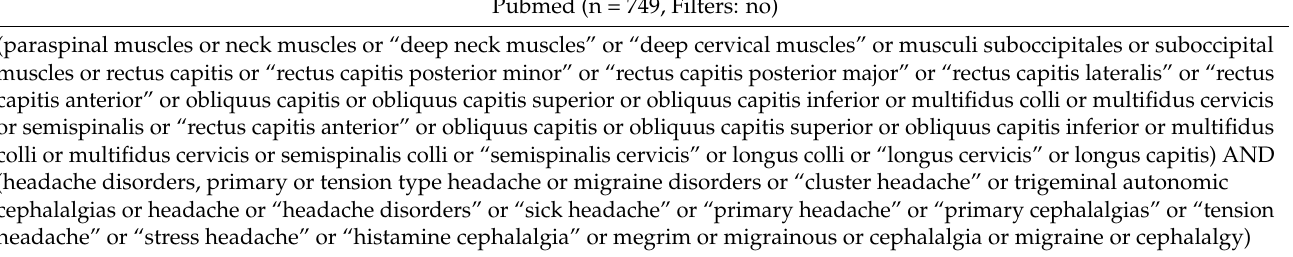
Table A2. Search strategy. This table describes the different combinations of terms used in each of the databases are grouped below: Pubmed, Medline, CINAHL, Web of Science and